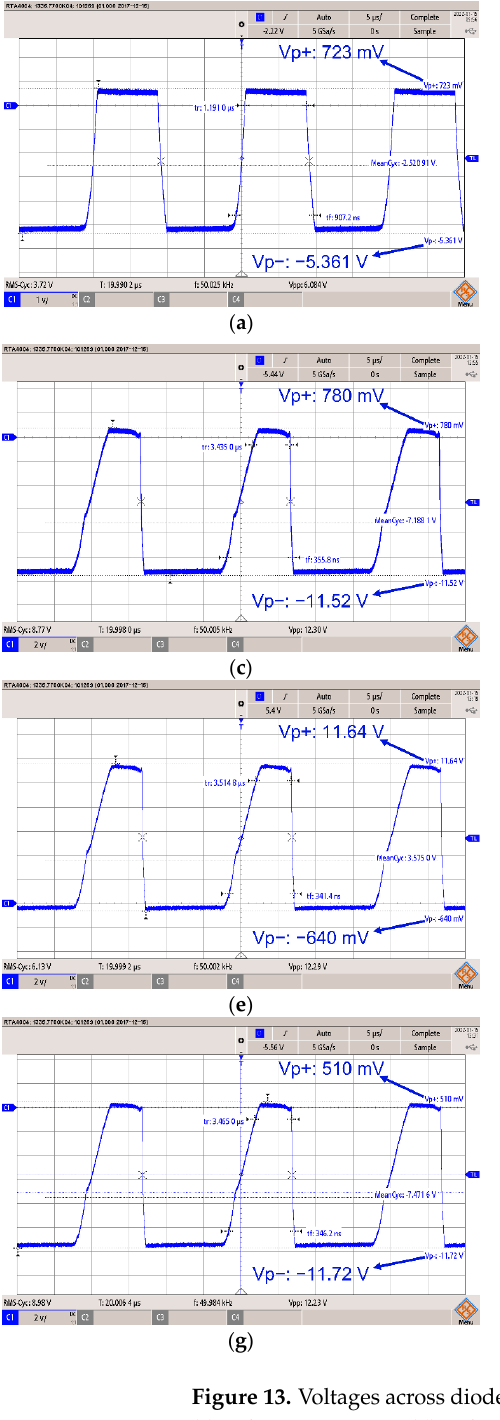
Figure 12. Voltages across capacitors at D = 0.5 and V in = 3V. ( a ) Voltage across C 1 , ( b ) voltage across C 2 , ( c ) voltage across C 3 , ( d ) voltage across C 4 , ( e ) voltage across C 5 , ( f ) voltage across C 6 , and ( g ) voltage across C 7.